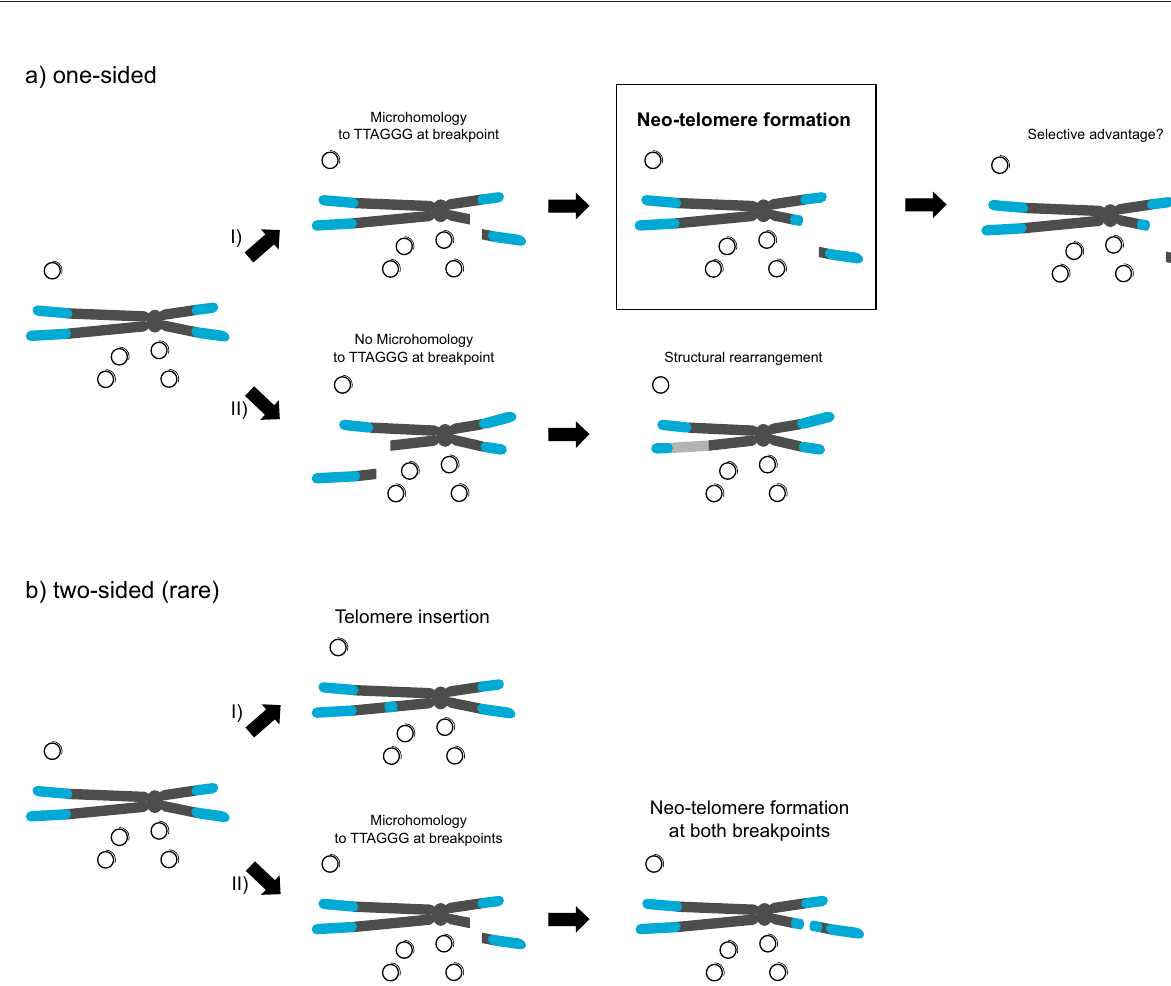
Fig. 7 Telomeric repeat loci. a Telomeric repeat loci frequency in ATRX -mutated (dark pink) and ATRX wild-type (light pink) ALT-positive tumors compared to TERT (blue), MNA (MNA), and tumors without genetic evidence of an activated telomere maintenance mechanism (OTHER, gray) in the discovery cohort. Boxplots indicate the median value (middle line) and the 25th and 75th percentiles (box). The upper/lower whisker spans from the hinge to the largest/smallest value (values expanding a distance of 1.5 x inter quartile range are not considered). Dots represent individual tumors. n describes the number of analyzed tumors. P values were calculated with two-sided Wilcoxon rank sum tests. b Example of one telomeric repeat locus in tumor NBD119. Dark blue color indicates sequencing coverage and light blue color illustrates clipped sequences. Reads are shown in medium gray and clipped bases are color-coded. Non-telomeric ends of a discordant read pair are labeled in dark gray. c Overall survival probability of ALT-positive tumors harboring more than three telomeric repeat loci compared to ALT-positive tumors with three or less than three events. P value calculated using a log rank test. d Chromosomal location of telomeric repeat loci in the discovery cohort. e Exact genomic location of events contributing to the hotspot on chromosome 1q42.2 in the discovery and INFORM cohort and two ALT-positive cell lines. The 1q42.2 events of NBD158 and NBD137 ware added manually (see Methods). f Chr1 copy number pro fi les of tumors with a telomeric repeat locus on chr1q42.2. Junction sites and orientation of telomeric repeats are indicated in orange. Color-coding according to subgroup (# HET ALT/MNA). g Differential mRNA expression of genes located in the chr1q42.2-1qter deleted region comparing 1q42-1qter deleted to non-deleted tumors. Genes are colored by their mean expression normalized by exonic length or by their presence in the TelNet database 22 . *) Matched primary relapsed pair.